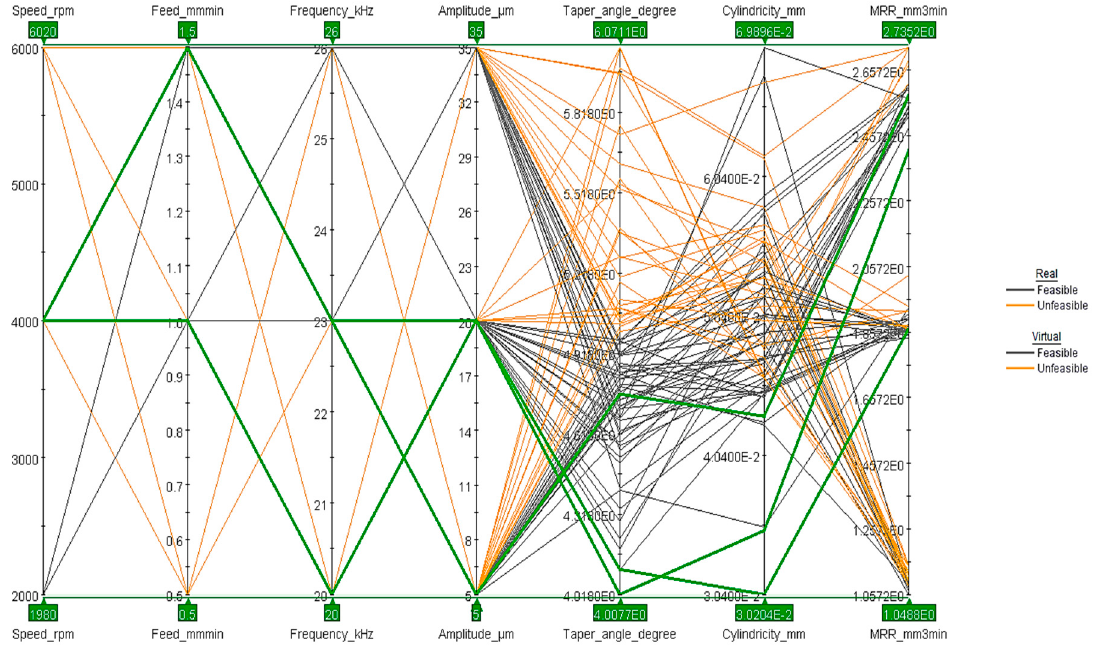
Figure 16. Parallel coordinate chart with all parameters. Table 6. Optimal solution points.